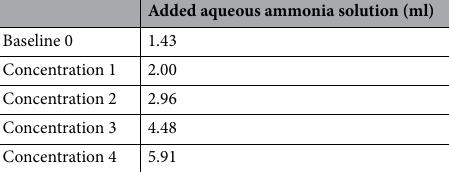
Added aqueous ammonia solution